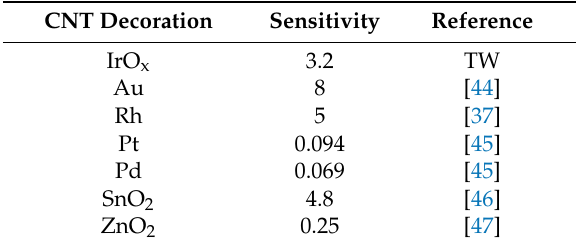
Table 3. Ammonia sensitivities reported as 10 − 2 % ppm − 1 for different metal nanoparticles decorating carbon nanotubes. TW = This Work.